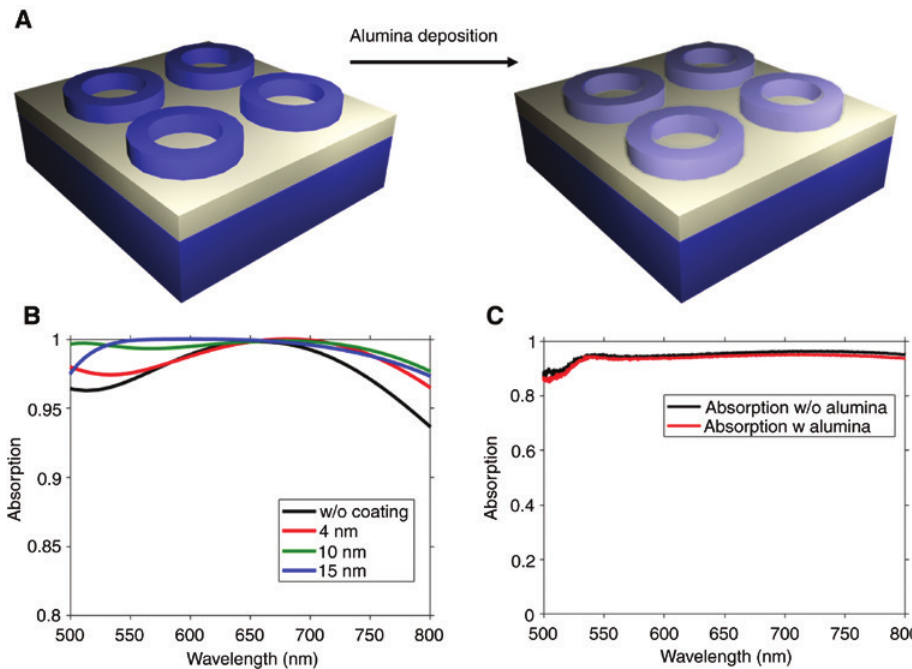
Figure 4: Protection layer coating